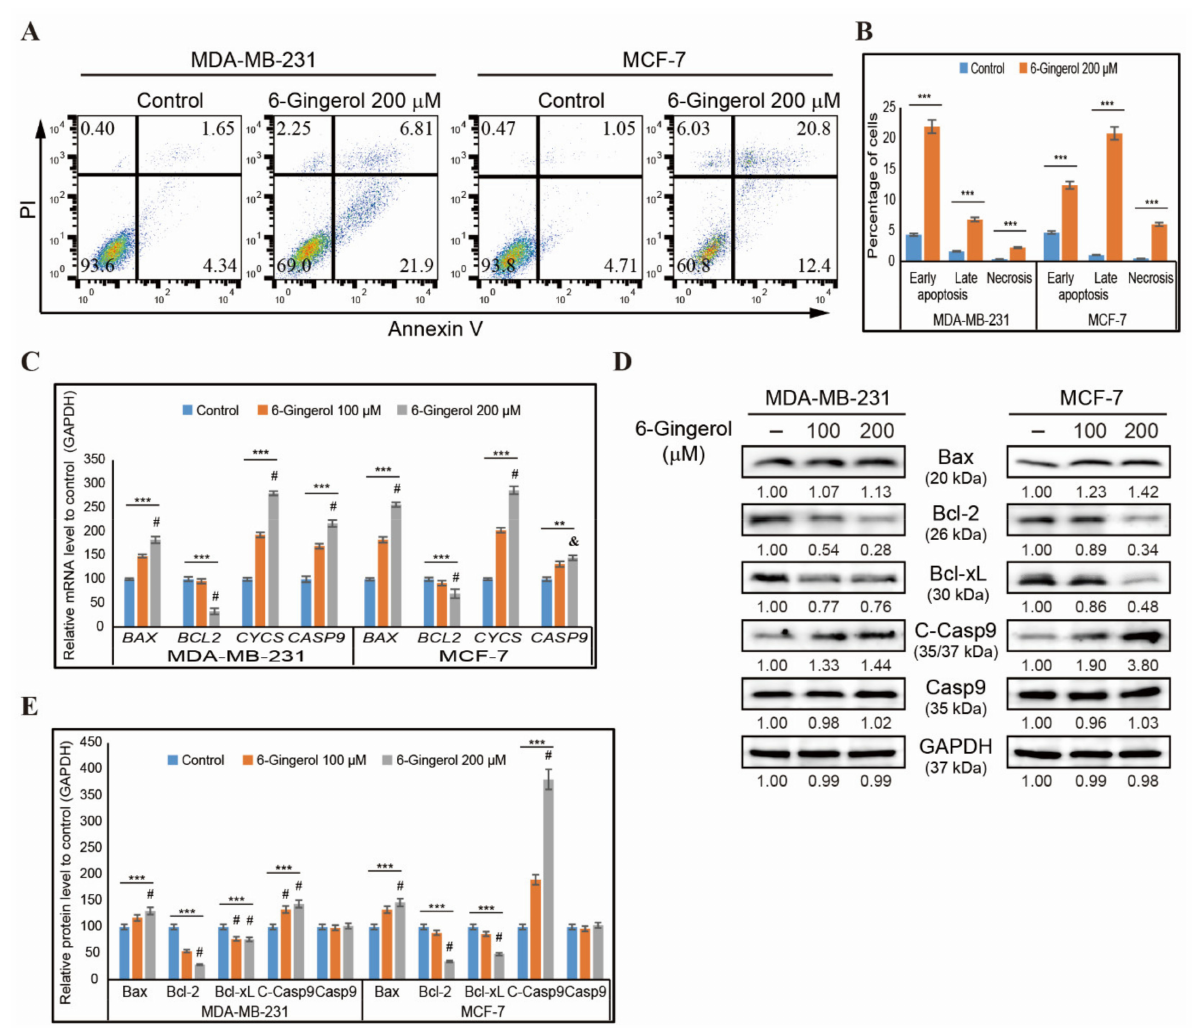
Figure 4. 6-Gingerol induces apoptosis. ( A ) Flow cytometry analysis using annexin V and PI staining in MDA-MB- 231 and MCF-7 cells after treatment with 6-gingerol for 48 h. ( B ) Graphical representation of the percentage of cells undergoing phases of apoptosis after treatment with 200 µ M of 6-gingerol in breast cancer cells. The values are presented as means ± SEM of three independent experiments performed in triplicate (n = 3). *** p < 0.001 (Student’s t -test). ( C ) qPCR analysis of expression of intrinsic apoptosis genes. The representative expression of the BAX , BCL-2 , CYCS , and CASP9 mRNA is shown; Cp values were then normalized to GAPDH mRNA. Controls are set to 100. ** p < 0.01 and *** p < 0.001 (ANOVA test), and & p < 0.01 vs. control. # p < 0.001 vs. control. ( D ) Western blotting analysis of MDA-MB-231 and MCF-7 cells after 48 h treatment with 100 and 200 µ M 6-gingerol showing the expression of BAX, BCL-2, BCL-xL, C-caspase 9, and caspase 9. ( E ) The representative expression of proteins was determined by densitometry and normalized to GAPDH. Controls are set to 100. Data were confirmed after repeating the experiment three times. *** p < 0.001 (ANOVA test). # p < 0.001 vs.